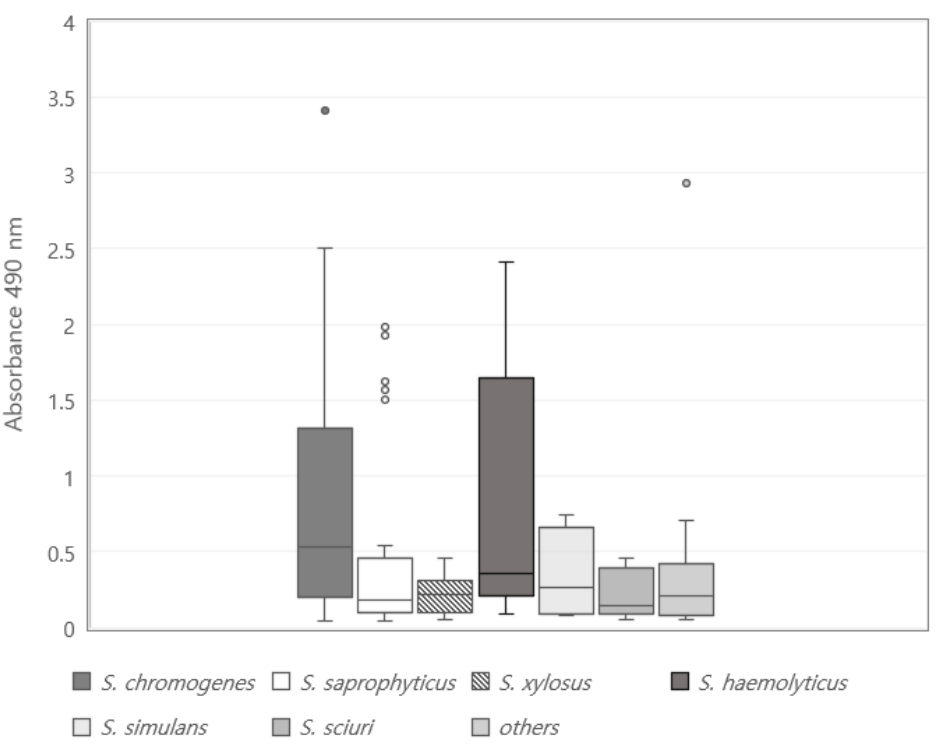
Figure 1. Distribution of strength to form biofilm in 162 coagulase negative staphylococci isolated from bulk tank milk. Points outside the box and whiskers are considered as outliers.